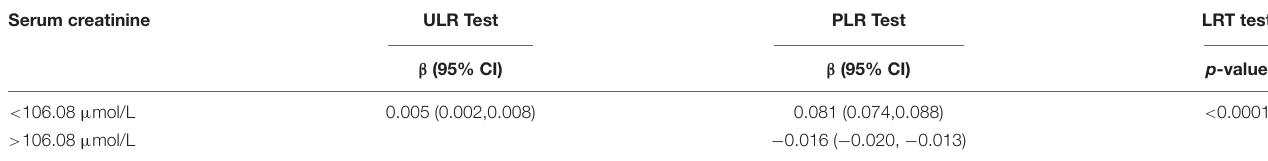
TABLE 5 | Two-piecewise linear regression and logarithmic likelihood ratio test explained the threshold effect analysis of serum creatinine on UCR. Serum